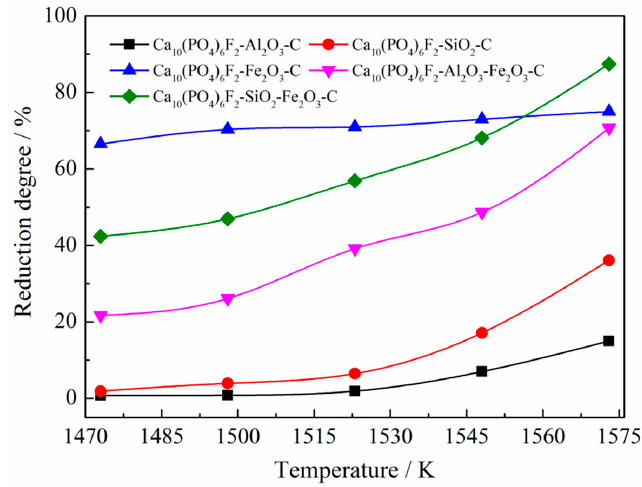
Figure 4. Effect of reduction temperature on the reduction degree of fluorapatite.